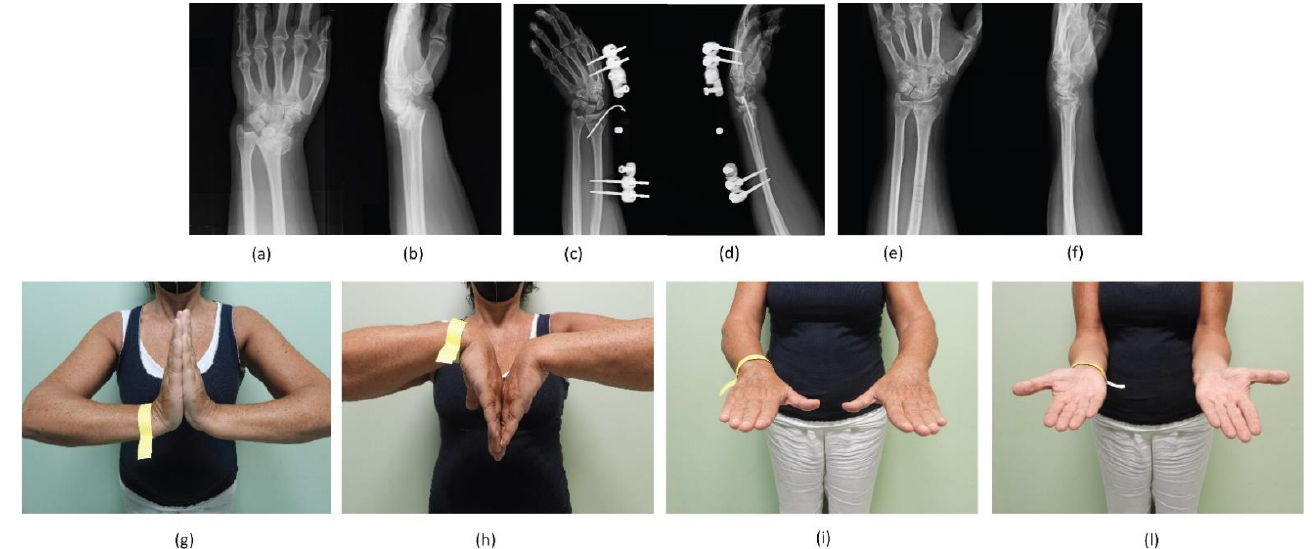
Figure 5. A 58-year-old female patient treated with BEF and an additional KW for an AO 23-C2 DRF. Antero-posterior (AP) and ( b ) latero-lateral (LL) radiographic images at ( a , b ) pre-operative period; ( c , d ) immediate post-operative period; ( e , f ) at 2-month follow-up. Clinical-functional images showing: ( g ) extension, ( h ) flexion, ( i ) pronation, and ( l ) supination of the operated wrist at last follow-up.